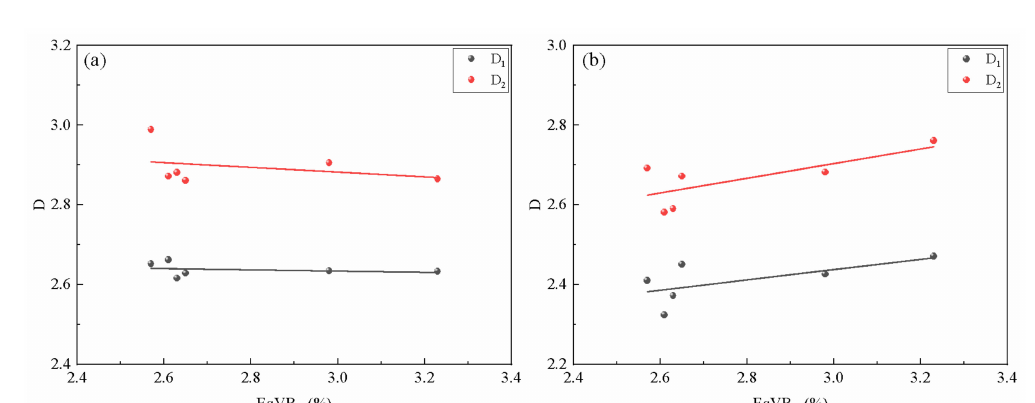
Figure 5. Cross-plots of EqVR o value versus fractal dimension (D 1 , D 2 ) of ( a ) bulk shale and ( b ) the isolated kerogen fraction of Wufeng–Longmaxi Formation shale samples (data are from